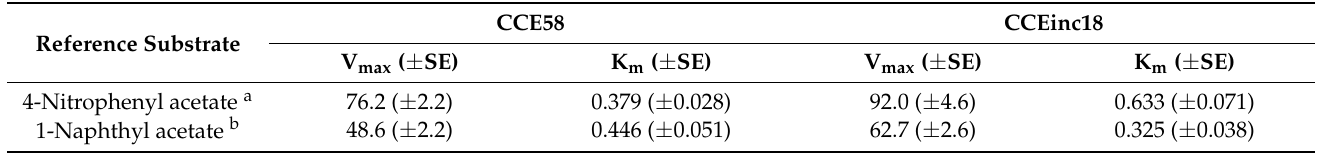
Table 2. Kinetic parameters of CCE reference substrates determined with 1 µ g protein of the recombi- nantly expressed MR-VL CCE58 and CCEinc18.